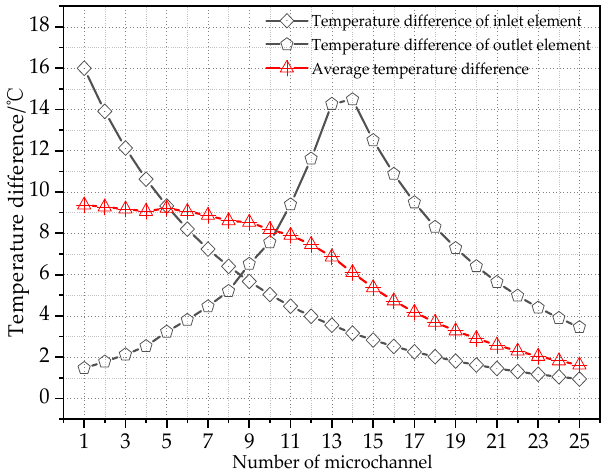
Figure 20. Temperature difference between air and refrigerant changing with the number of micro- channels.